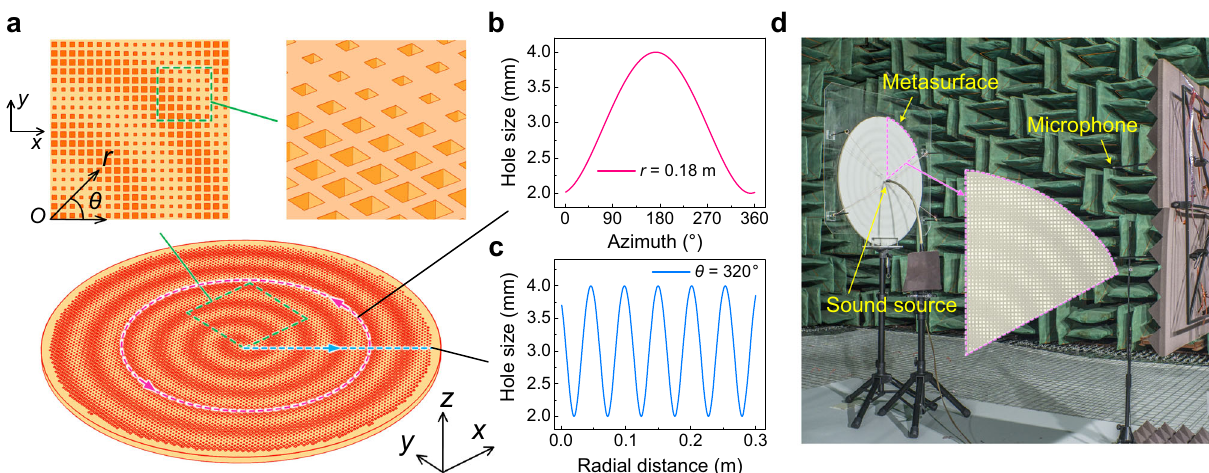
Fig. 3 Planar acoustic antenna design. a Schematic diagram. The structure details in the green dashed squares are shown in expanded schematic form (square insets). b , c Plot of the geometric parameters that are implemented. The pink solid (blue solid) curve illustrates the pro fi le of hole size a along the pink dashed circle (blue dashed hatching line) in the circumference (radial) direction. d Experimental setup. The fanshaped inset shows partial enlarged